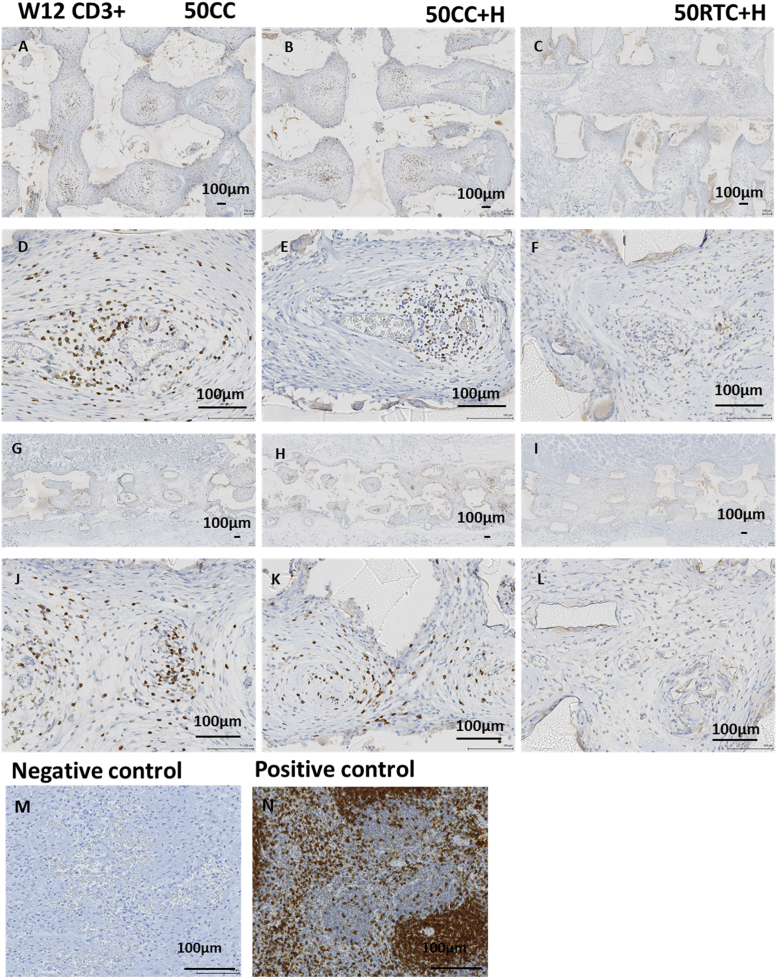
Immunohistochemistry of the host T lymphocyte response towards scaffolds in vivo at week 12. Tissue integration of middle-in-plane (A-F) and cross-sectional view (G-L) of the scaffolds by CD3 (T lymphocyte marker) staining at (A-C, G-I) ×4 and (D-F, J-L) ×20 magnifications. (M) Negative control (rat appendix); (N) positive control (rat spleen). Scale bar: 100 μm.